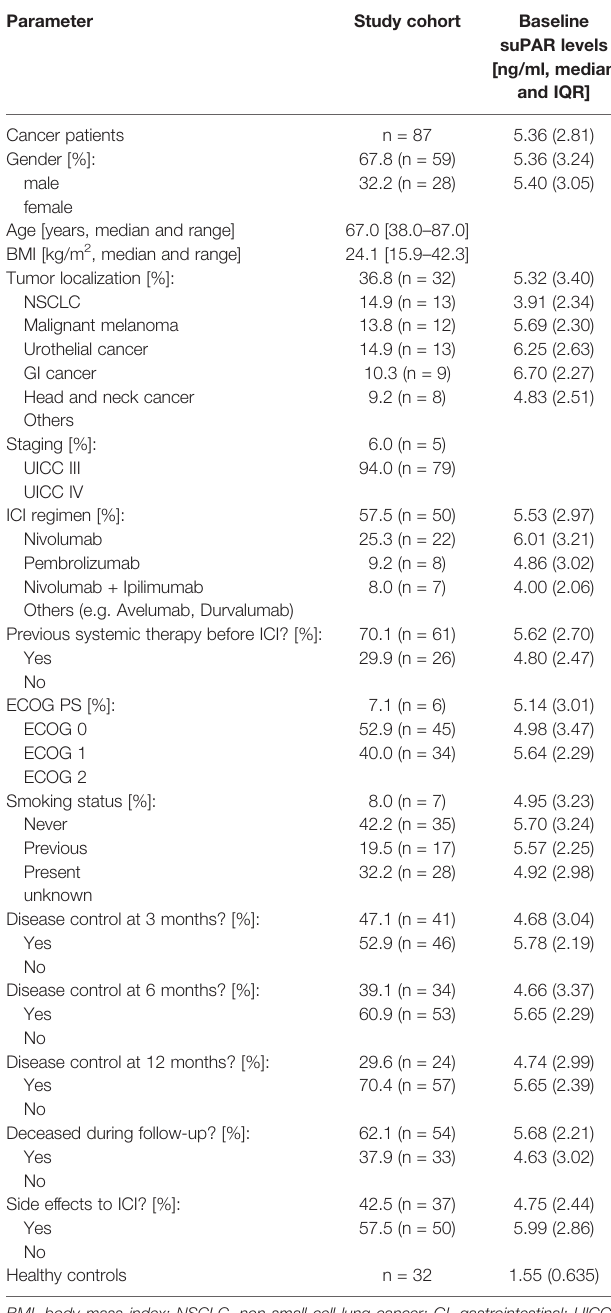
TABLE 1 | Patient